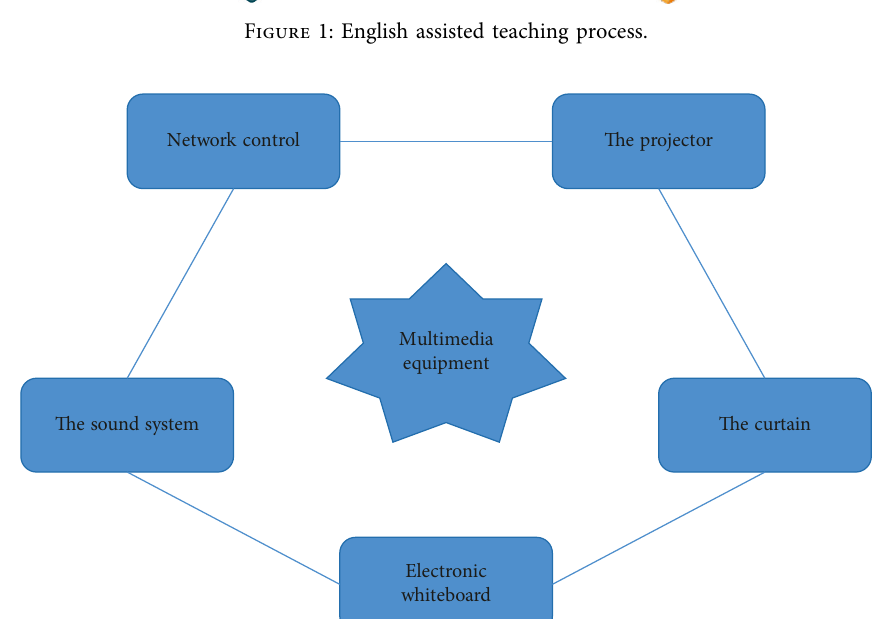
Figure 2: Multimedia equipment